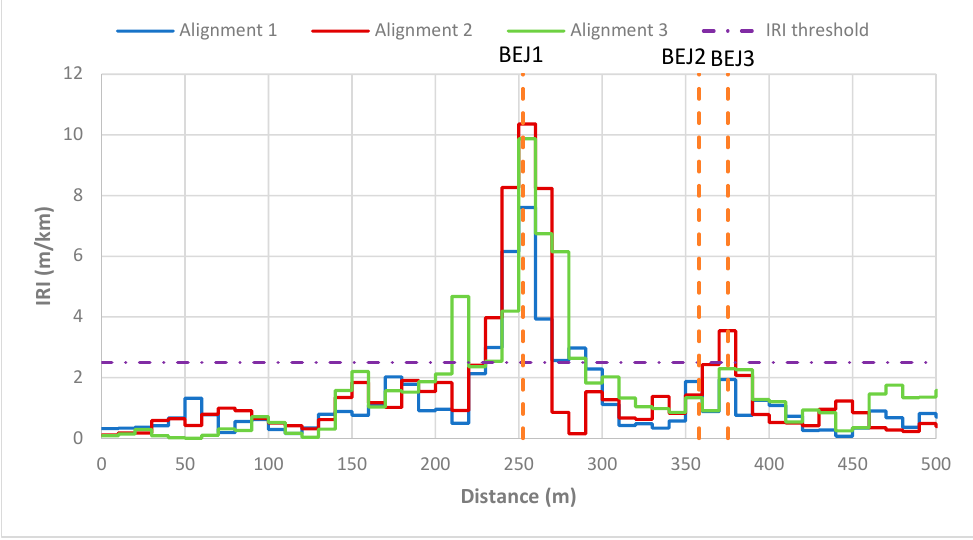
Figure 15. International roughness index (IRI) values calculated on a segment of 10 m.